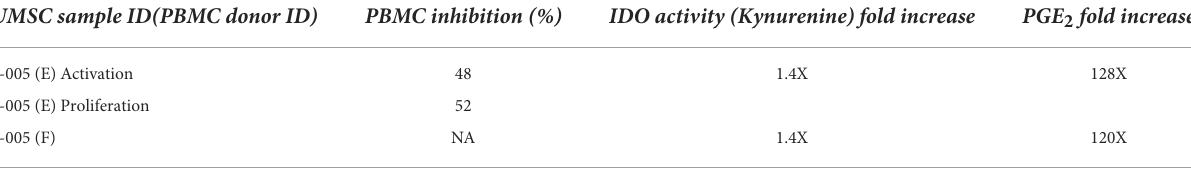
TABLE 1 Percentage inhibition of con A-induced PBMC activation and proliferation in the presence of UMSCs. UMSC sample ID(PBMC donor ID)